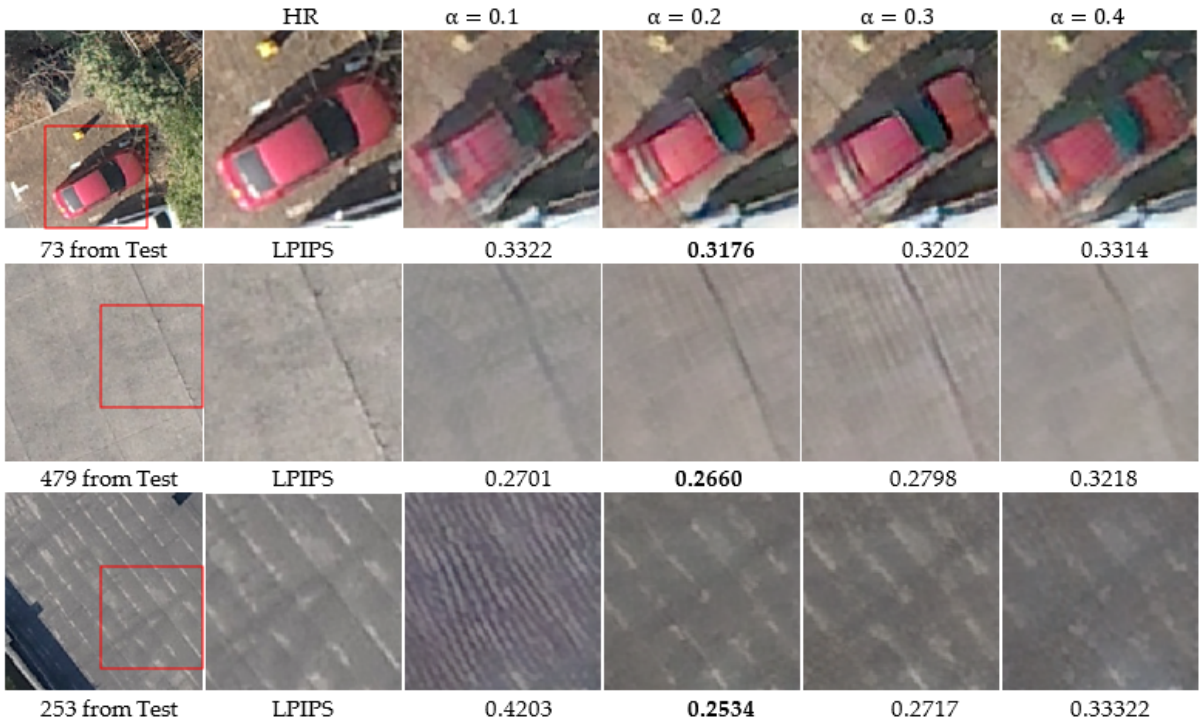
Figure A2. Experimental results of the model corresponding to different residual scaling factors, where 𝛼 represents the residual scaling factor. The best performance in bold.